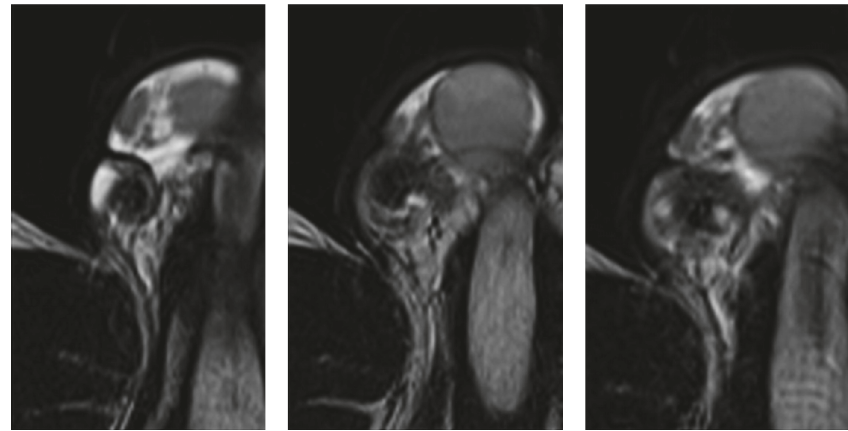
Figure 1: Axial T2-weighted images demonstrating right twisted spermatic cord.